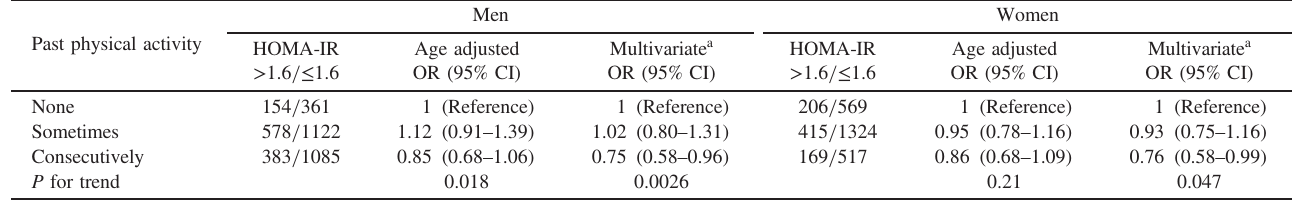
Table 3. The odds ratio of insulin resistance (HOMA-IR > 1.6) associated with past physical activity Past physical